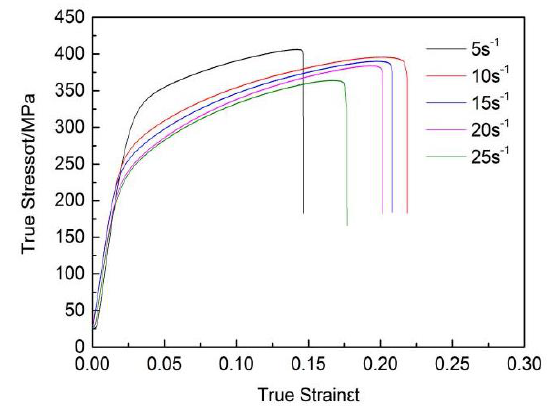
Figure 7. True strain-true stress curve for rolled sheets under different strain rates. Table 2. Tensile properties for the rolled sheets with different strain rates. Strain Rate (s − 1 ) Tensile Strength